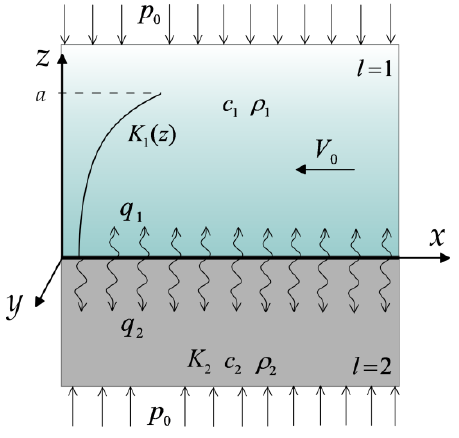
Figure 1. Scheme of the problem.